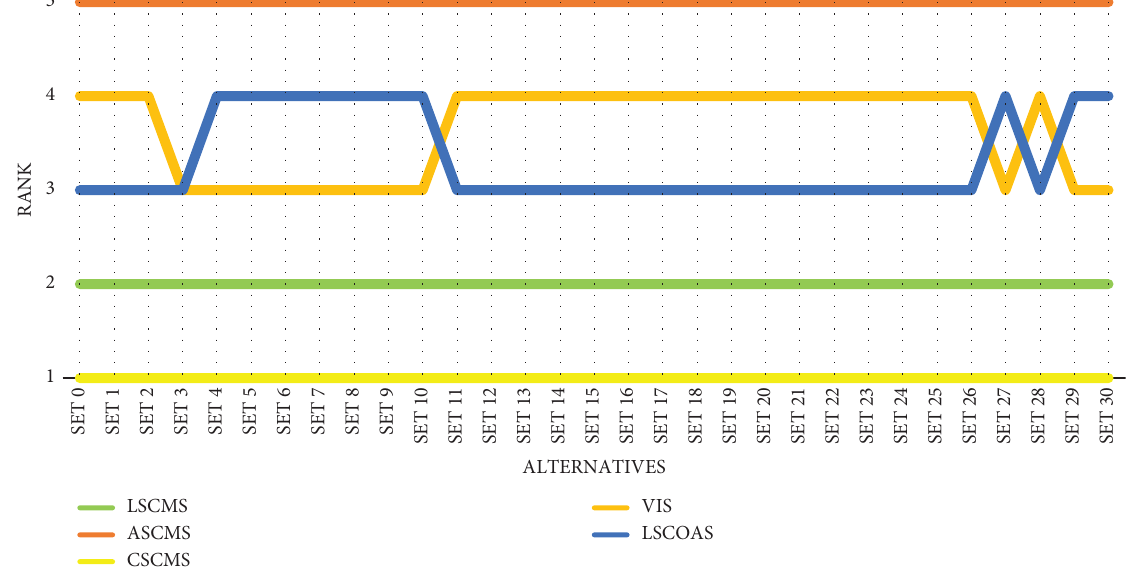
Figure 2: 30 new scenarios in a sensitivity analysis. Table 10: Te results of rough methods.